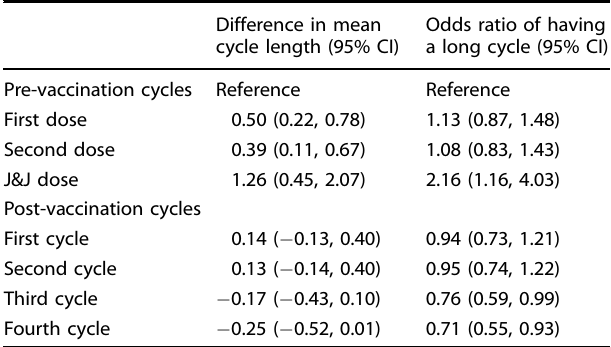
Table 2. Adjusted within-participant change in mean menstrual cycle length and 95% con fi dence intervals (95% CIs) and adjusted odds ratios (ORs) and 95% CIs of experiencing a long menstrual cycle (>38 days) comparing cycles in which a vaccine was administered and post-vaccination cycles with pre-vaccination